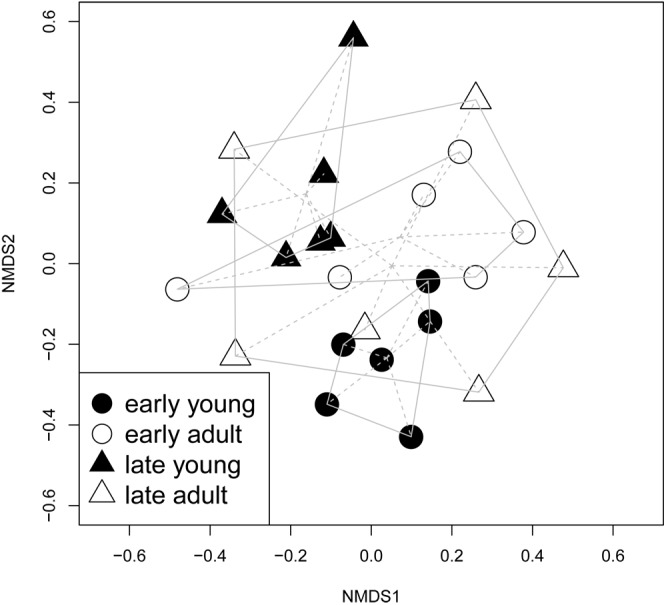
Ectomycorrhizal (ECM) fungal community ordination plot based on communities from early/late flushing and adult/young silver fir trees, calculated on a Bray-Curtis distance with a non-metric multidimensional scaling analysis (NMDS) ordination. Presented are centroids of each groups of samples. The ECM community significantly differs between early and late flushing young silver fir trees (PERMANOVA, P = 0.003), but not between early and late flushing adult silver fir trees (PERMANOVA. P = 0.9910).